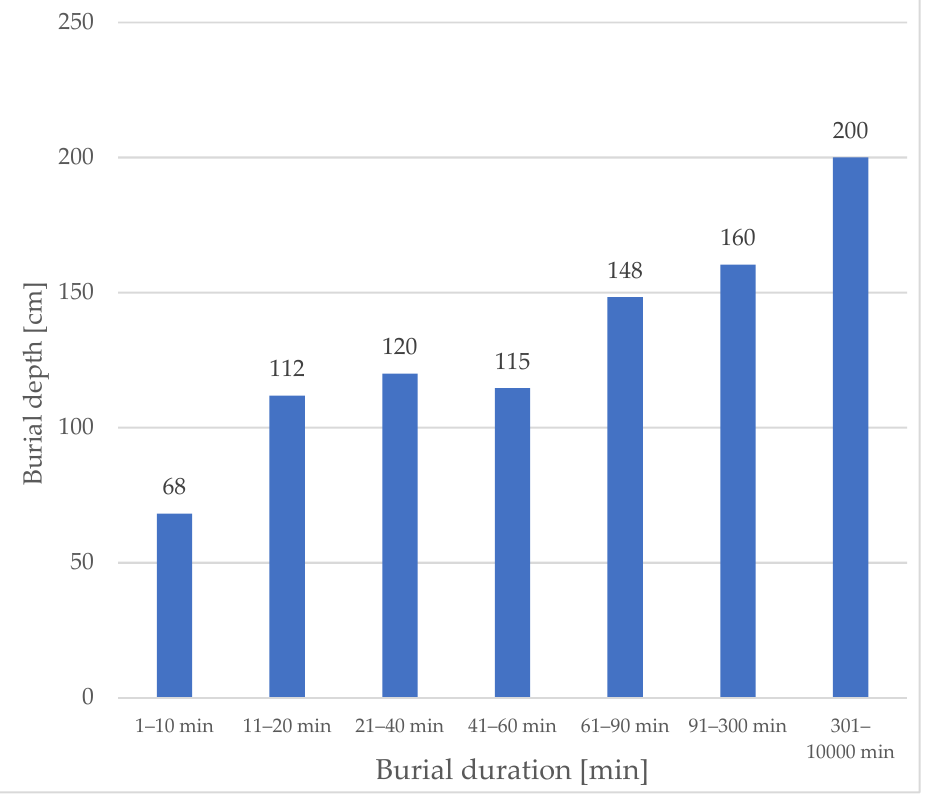
Figure 2. Mean burial depth of excavated subjects for different burial duration ranges. N = 1070.